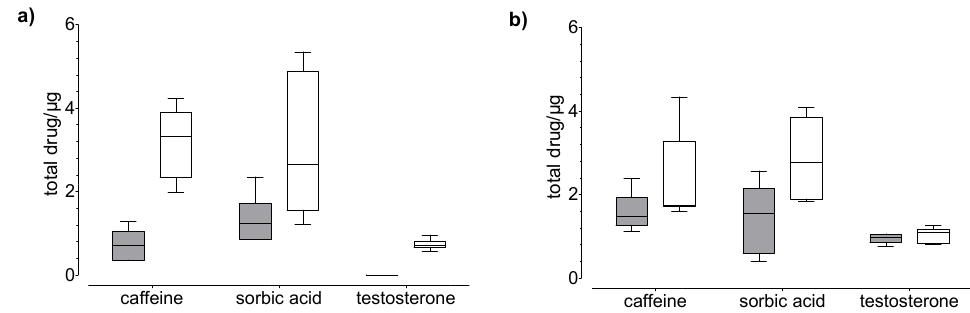
Figure 5. Results of the drug ( a ) permeation through and ( b ) penetration into nail (grey) and hoof (white) membrane after 120 h of exposure to caffeine, sorbic acid, and testosterone (donor: 20 µg). Box plot with median, minimum, maximum, and the 0.25 and 0.75 quartiles, n = 6. A linear correlation was found between the penetrated and the permeated amount of the drug in the human nail and that in the equine hoof membrane, respectively (Figure for drug hoof [ µ g ] − 0.499 the penetrated drug, drug nail [ µ g ] = for the permeated drug and 1.480 drug hoof [ µ g ] − 0.757 drug nail [ µ g ] = for total drug 1.544